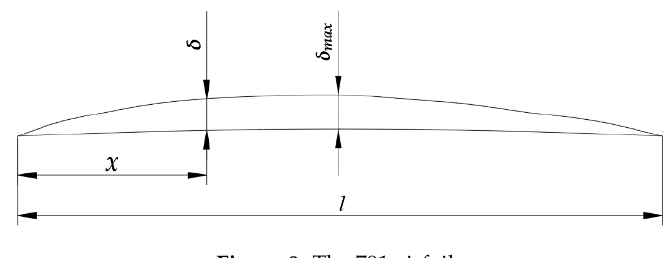
Figure 8. The 791 airfoil.